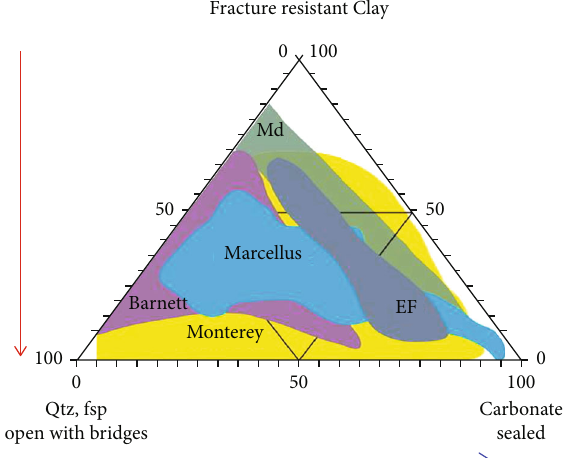
Figure 1: Mineral composition and fracture development